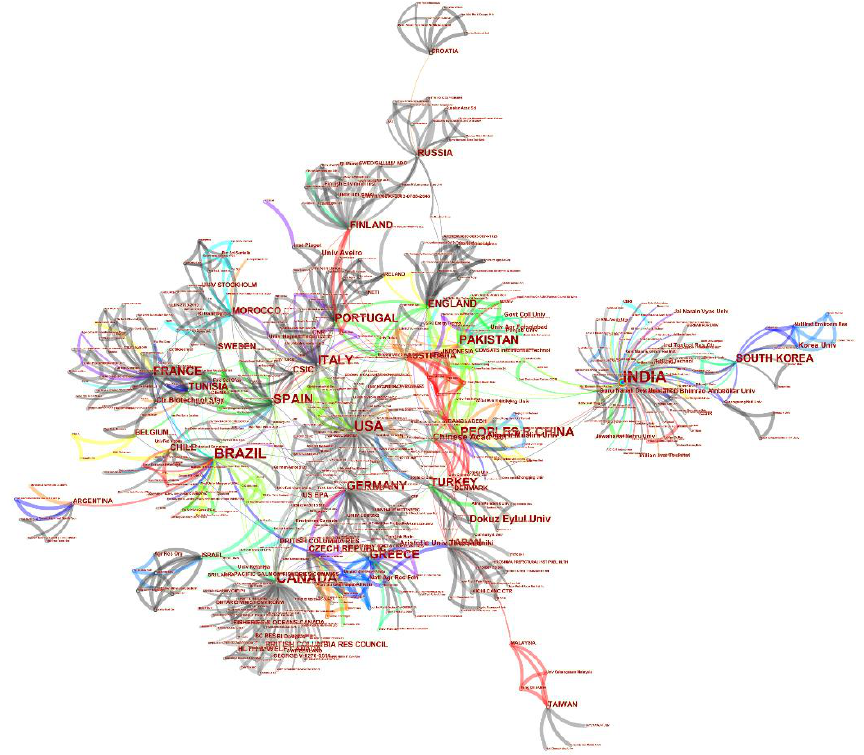
Figure 7. The analysis regarding the contributing countries and institutions in the field of industrial effluent and sludge toxicity from 1951 to 2020. This analysis has been achieved via the utilization of CiteSpace software.